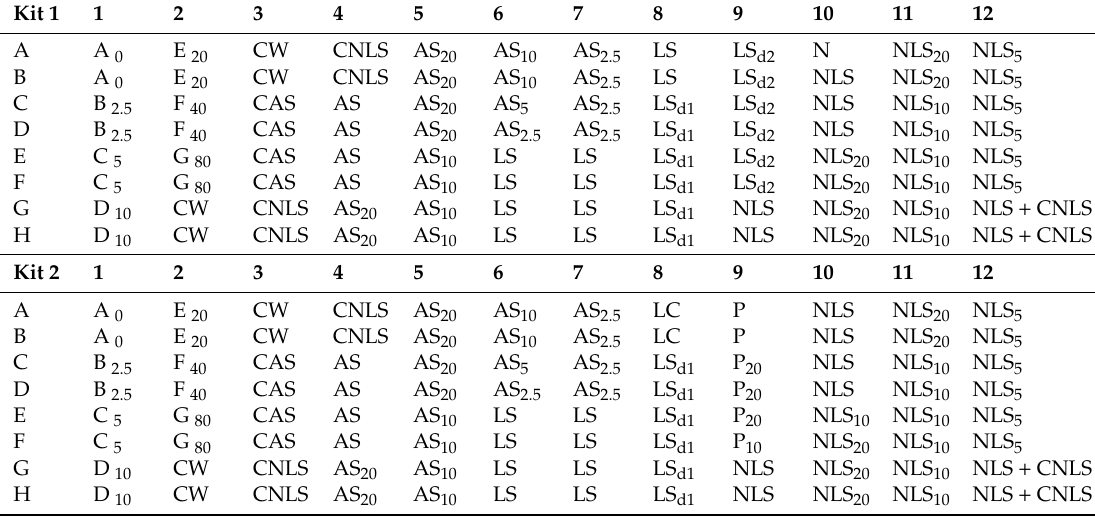
Table A1. Outline distribution adopted for the validation procedure. Details of the wells for kit 1 and kit 2. The only di ff erence is that the second dilution for lactating female saliva (LS dil2 ) was replaced in kit 2 by saliva from a di ff erent pool of domestic dogs (saliva as such -P-, and two dilutions of it -P 20 and P 10 -). Caption: A-G (reconstitute lyophilized canine prolactin master calibrators), CW (control dissolved in water), CAS (control dissolved in artificial saliva), CNLS (control dissolved in non-lactating dogs saliva), AS 20 -AS 2.5 (artificial saliva with addition of the standards), LS (lactating dogs saliva pool), LS d1 -LS d2 (dilutions of lactating dogs saliva pool), NLS (non-lactating dogs